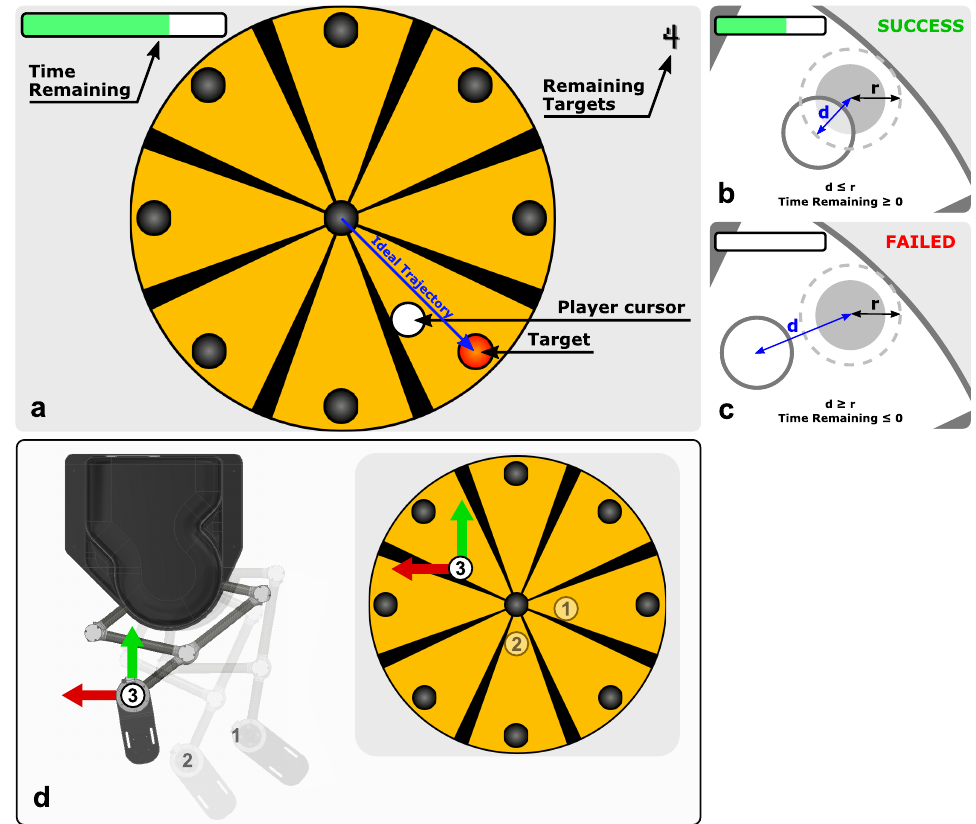
Figure 3. Overview of the game. ( a ) A screenshot of the game. ( b ) Condition to successfully reach the target, where d is the distance of the player cursor to the target and r is the minimum distance to reach the target successfully. ( c ) Condition to fail the reach of the target. ( d ) Movement of the robot in correlation with the proposed